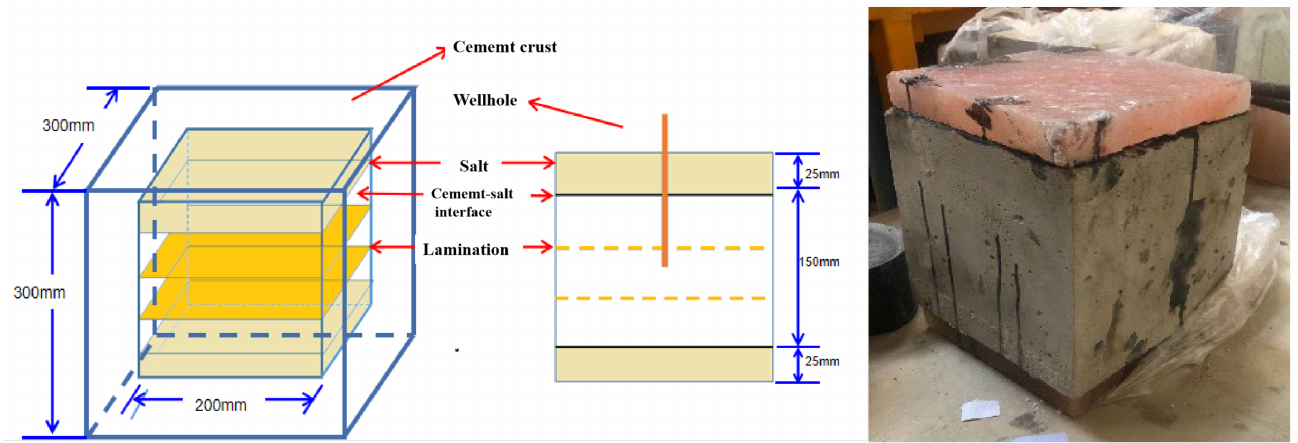
Figure 8. Schematic diagram of sample structure.